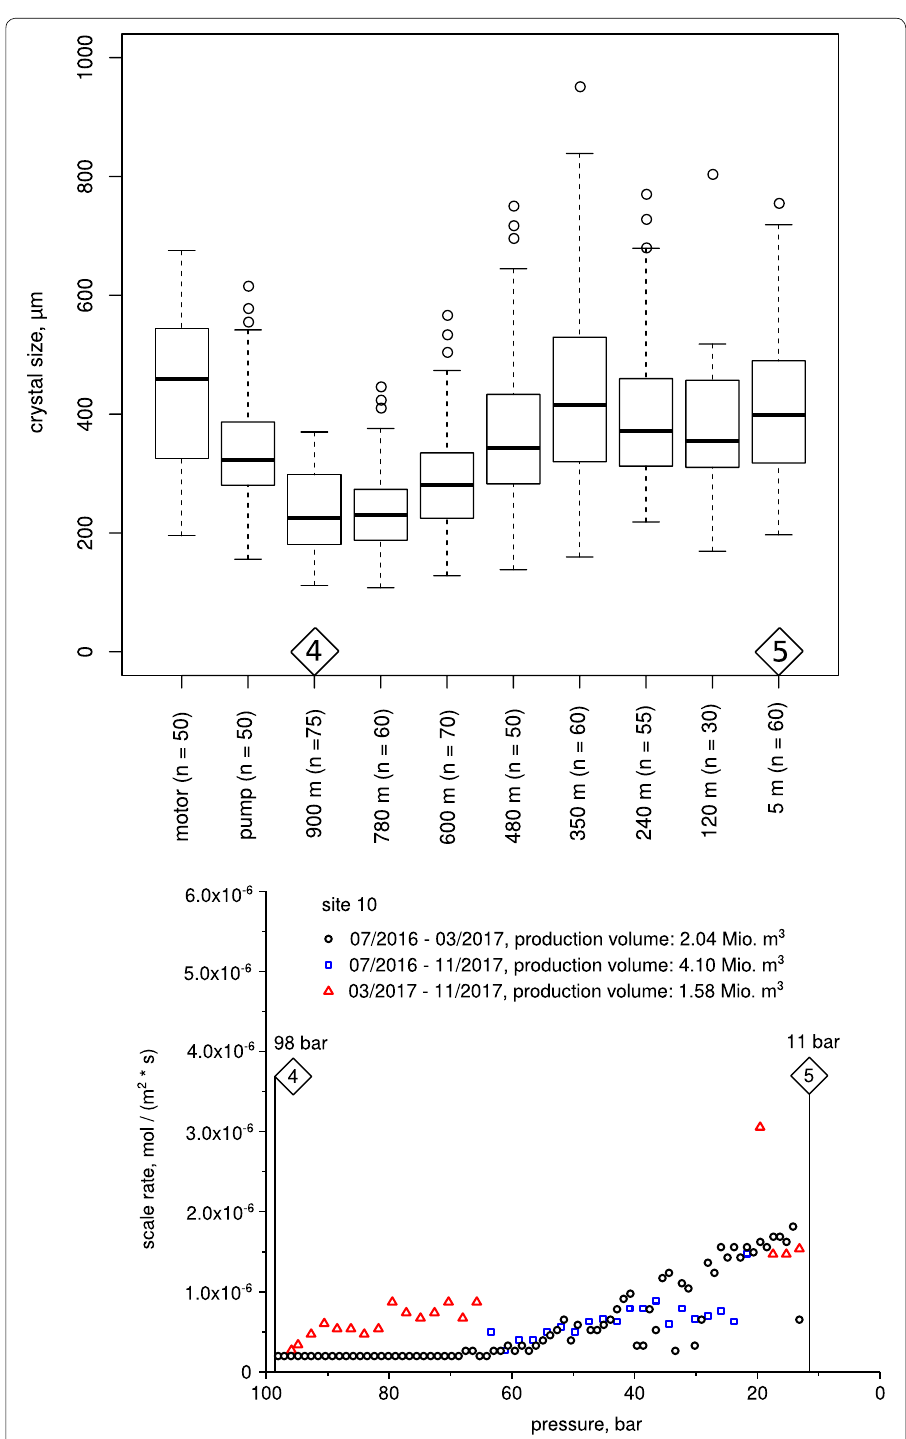
Fig. 6 Crystal sizes and scale rate at one facility measured at the water side at different depths, here site 10 as an example. The crystal sizes at other facilities show the same increasing trend from the pump outlet (simulation point 4) to the wellhead (simulation point 5). n number of =